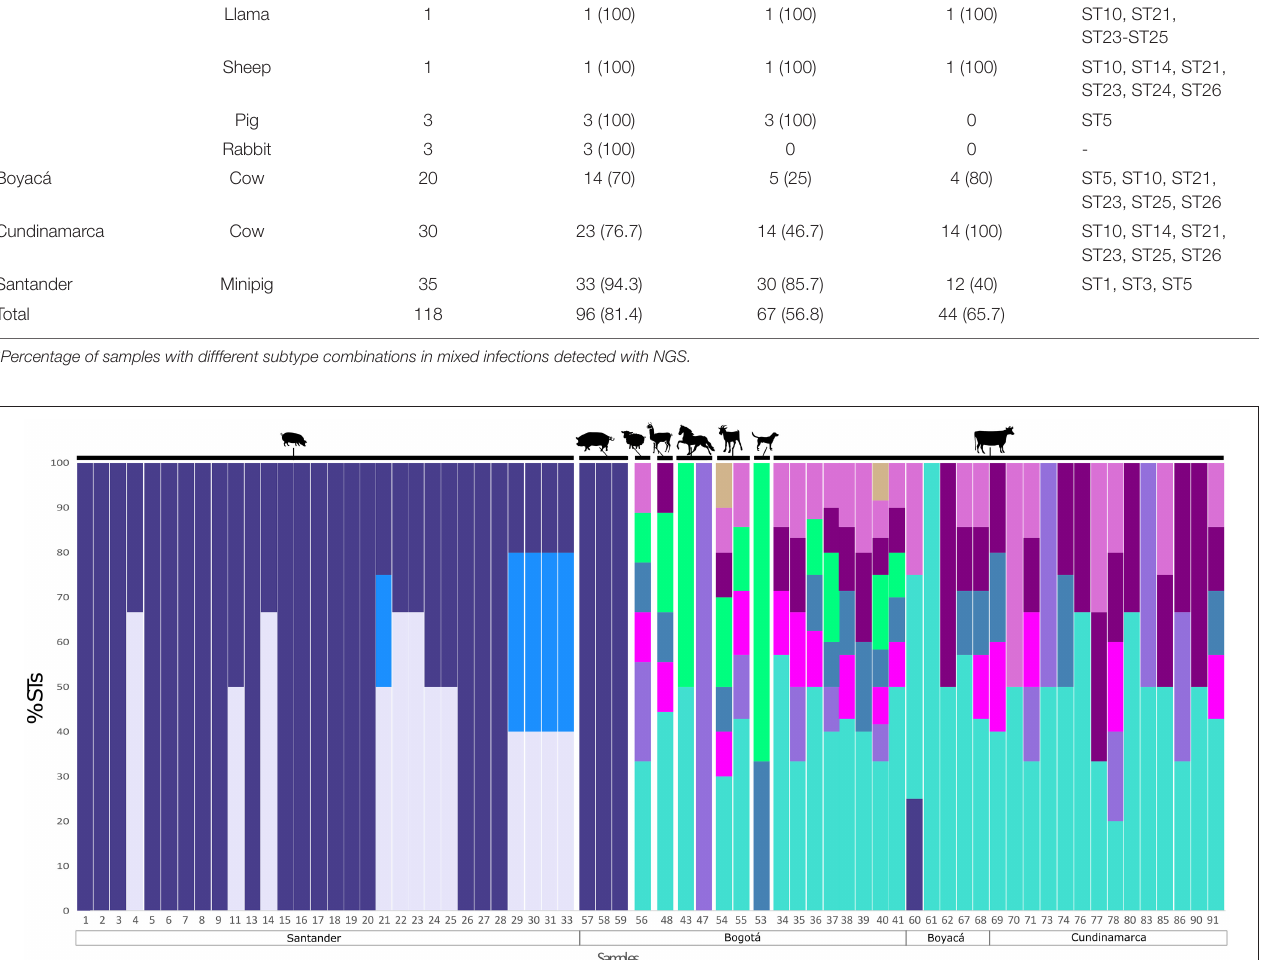
sequence of the SSU rRNA gene should be obtained. A MinION long read sequencing strategy was applied to one goat sample which contained the novel subtype (sample #54). A full-length sequence of the SSU rRNA gene was successfully obtained for the novel subtype. Multiple subtypes were present in sample number 54, and five additional full-length nucleotide sequences